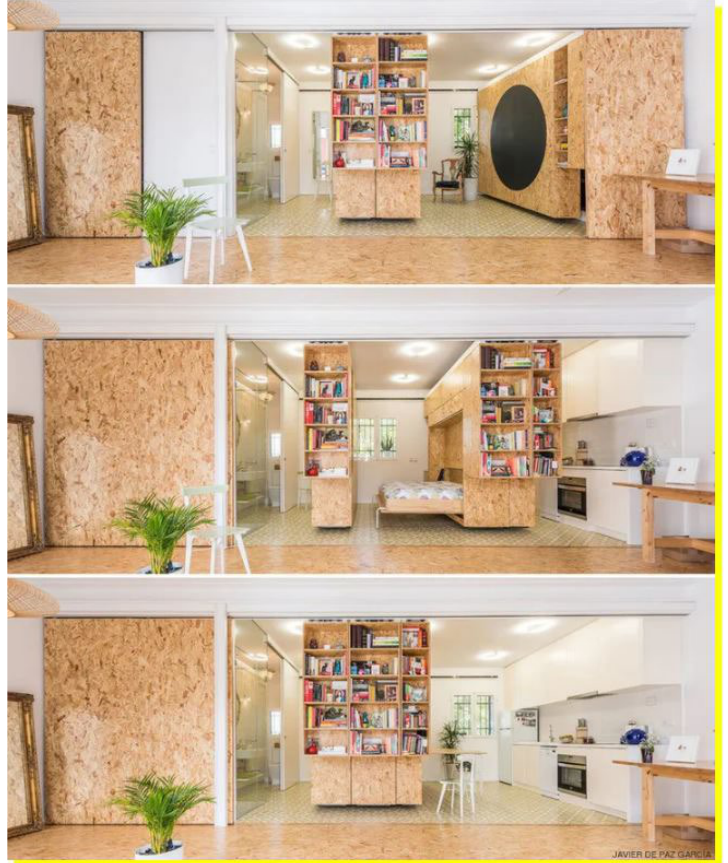
Figure 2 Movable wall solution by Madrid based architectural studio PKMN-Architectures, photographed by Javier de Paz Garcia (Huffpost,